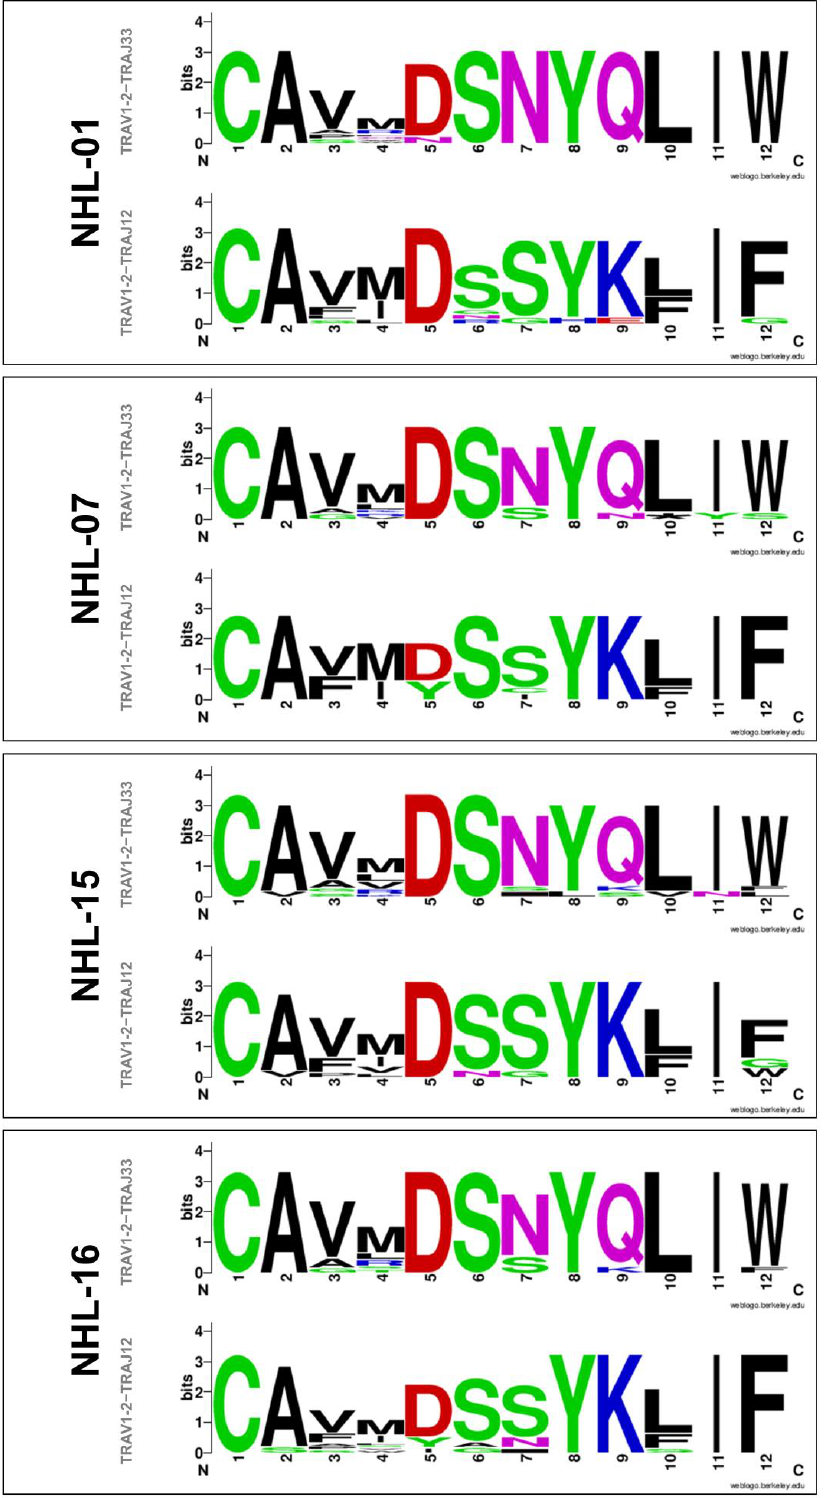
Figure 3. Amino acid sequence logos corresponding to the CDR3 α region resulting from MAIT cells TRAV1-2 − TRAJ33 or TRAV1-2 − TRAJ12 rearranged genes found in T-lymphoma biopsies. Amino acids (represented by letters of various heights) in the different positions are shown on the x -axis. The height of each letter in a column is proportional to the amino acid frequency in that position. The total height of the column represents the conservation of the sequence in that position (measured in bits, y